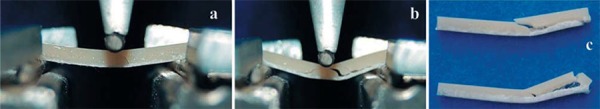
Specimens of fiber reinforced material: (a) close to the first failure point, (b) after major failure, and (c) after the bending tests